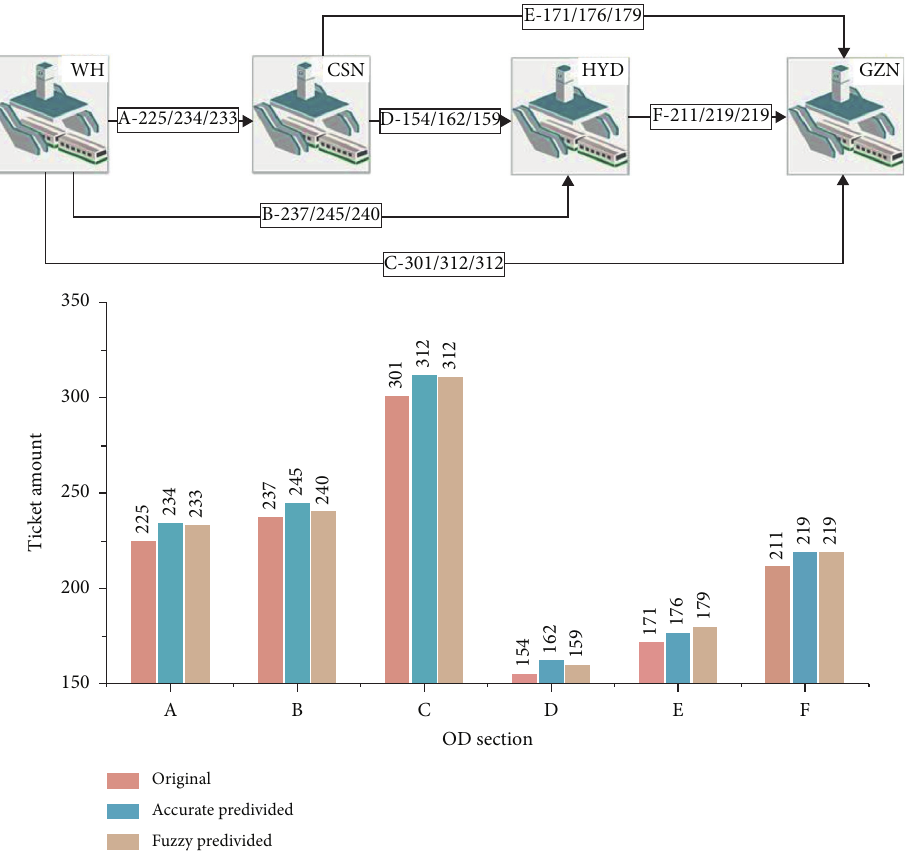
Figure 12: The ticket selling result of three modes: original/accurate predivided/fuzzy predivided. Table 4: The result of different O&D demand and ticket amount under accurate and fuzzy predivided models.